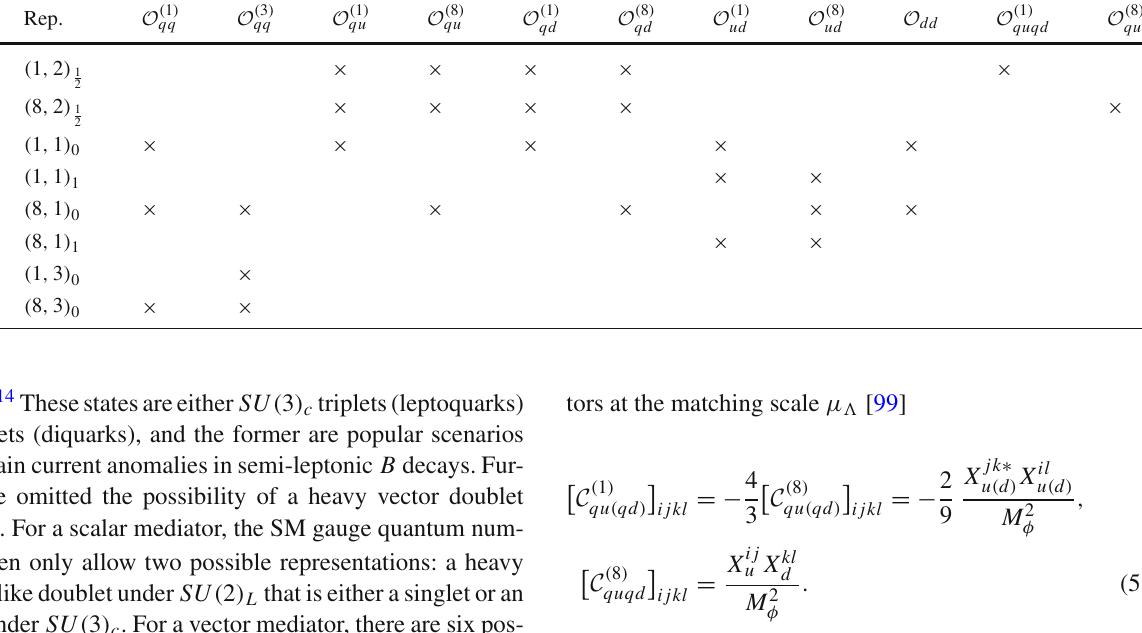
Table 3 Four-quark SMEFT operators containing down-type quarks generated by the exchange of scalar or vector mediators at tree level. The second column gives the representation under G SM = SU ( 3 ) c ⊗ SU ( 2 ) L ⊗ U ( 1 ) Y Spin